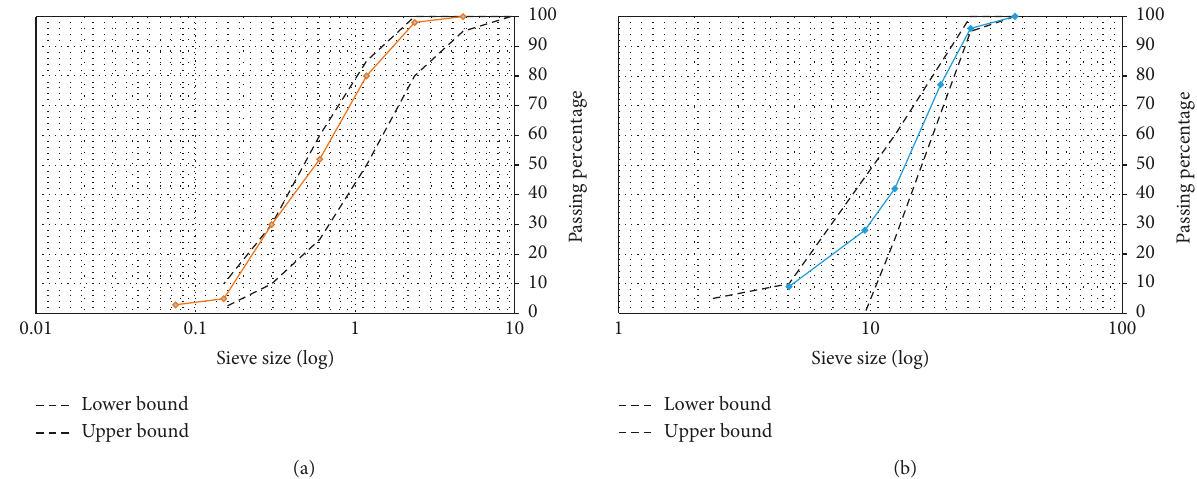
Figure 3: Gradation curves of the aggregates with the upper and lower standard limitations. (a) Fine aggregates. (b) Coarse aggregates.